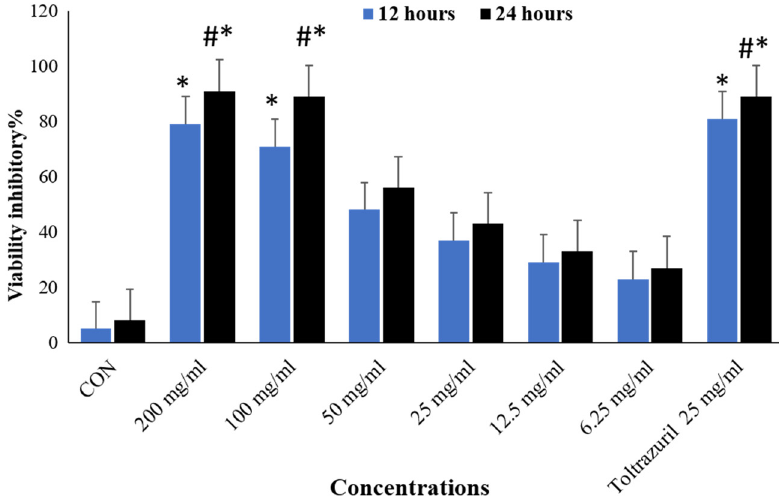
Figure 7: E ff ects of CPLE on sporozoite viability inhibitory of E. Papillata of di ff erent concentrations after 12 and 24 h in vitro . The signi fi cance was compared to potassium dichromate 2.5% as a negative control and Toltrazuril 25 mg/mL as a positive control. ( *# ) : p - value ≤ 0.001 and ( * ) : p - value ≤